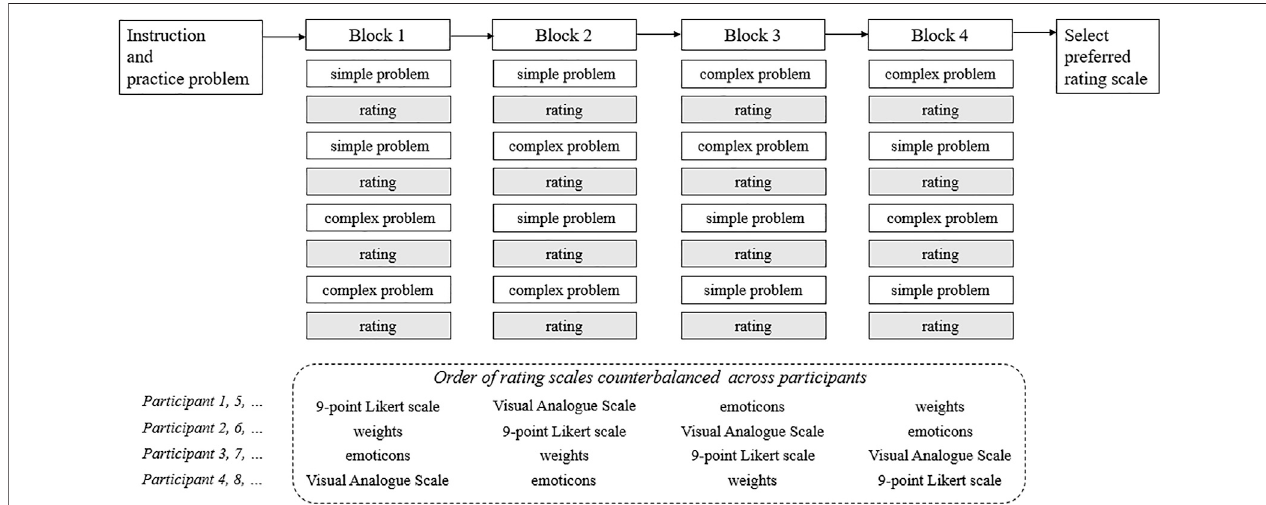
FIGURE 2 | Overview of the procedure of the